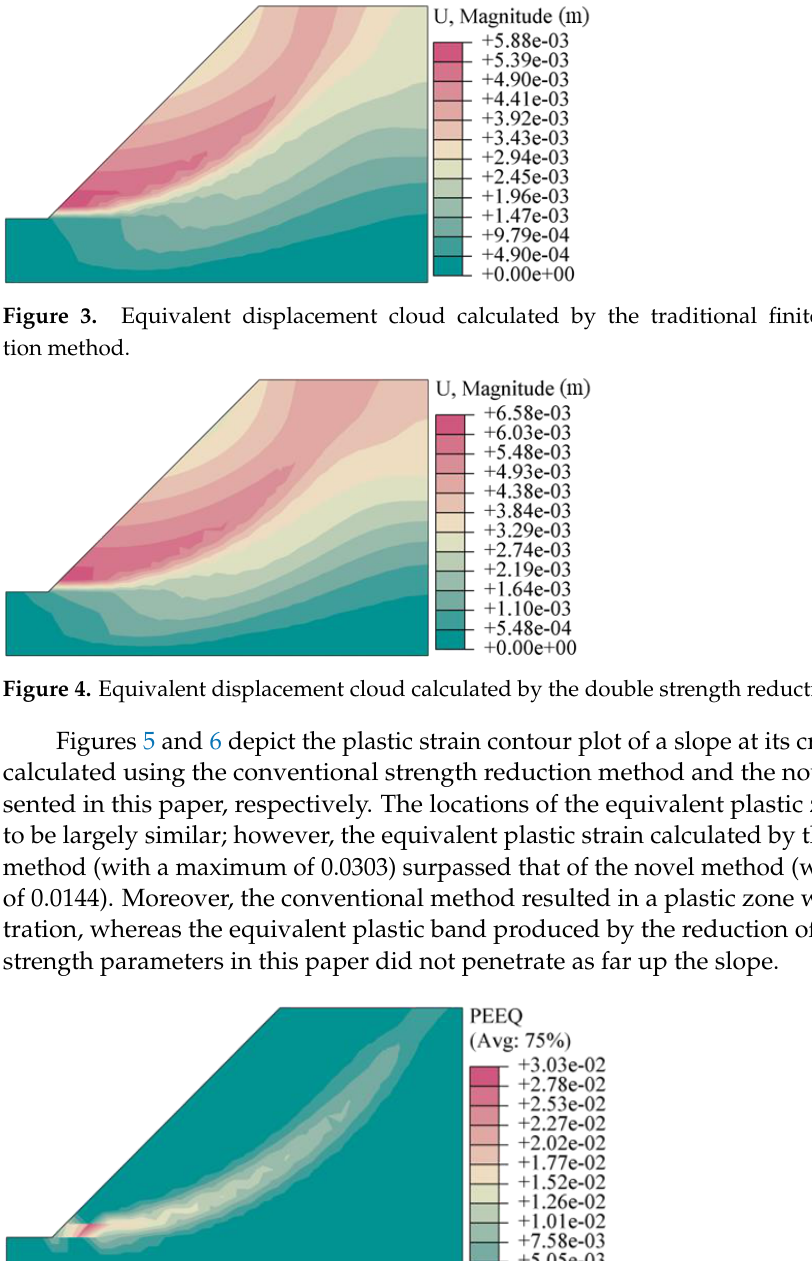
Figure 6. Equivalent plastic strain cloud calculated by the double strength reduction method. This slope model was integrated into the Slope module of the GeoStudio software, and the limit equilibrium approach was used to calculate the slope ’ s safety factor, specif- ically the Morgenstern – Price strip division method. Figure 7 displays the outcome of the crucial sliding surface calculation. Figure 7. Critical slip surface calculated by the limit equilibrium method.